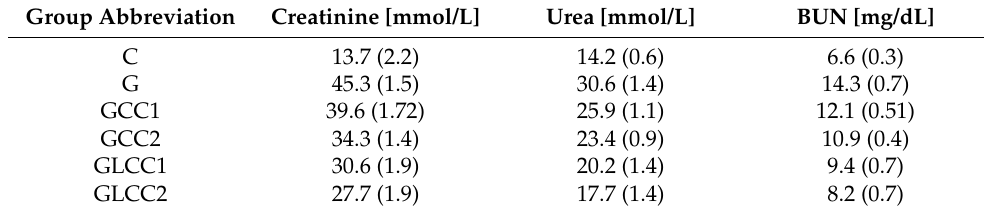
Table 4. Serum levels of renal function